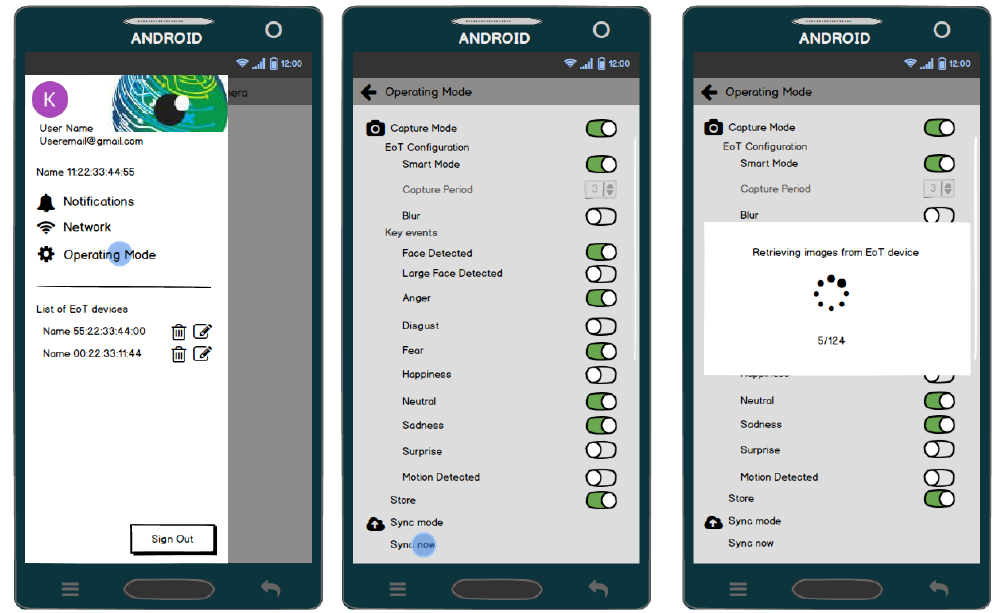
Figure 22. Sample screens of the demonstrator’s Android app.